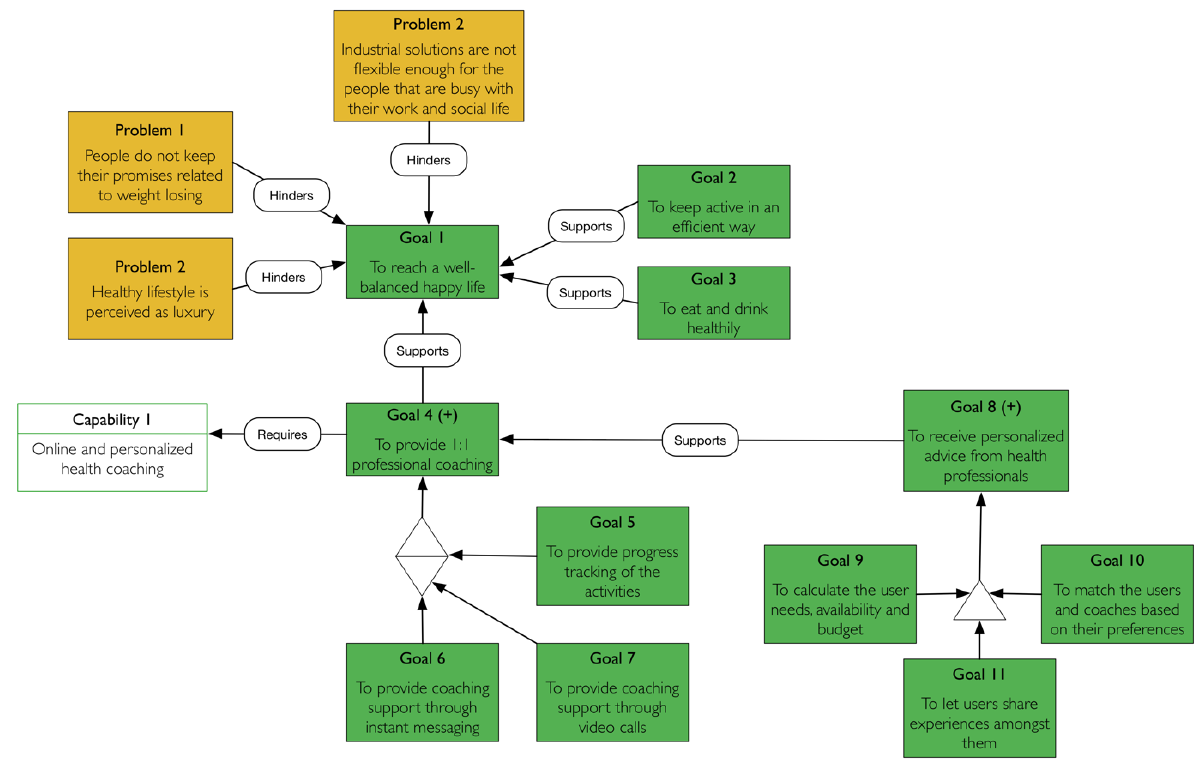
Figure 7 . Core business idea and the assessment of user needs from goals perspective Design